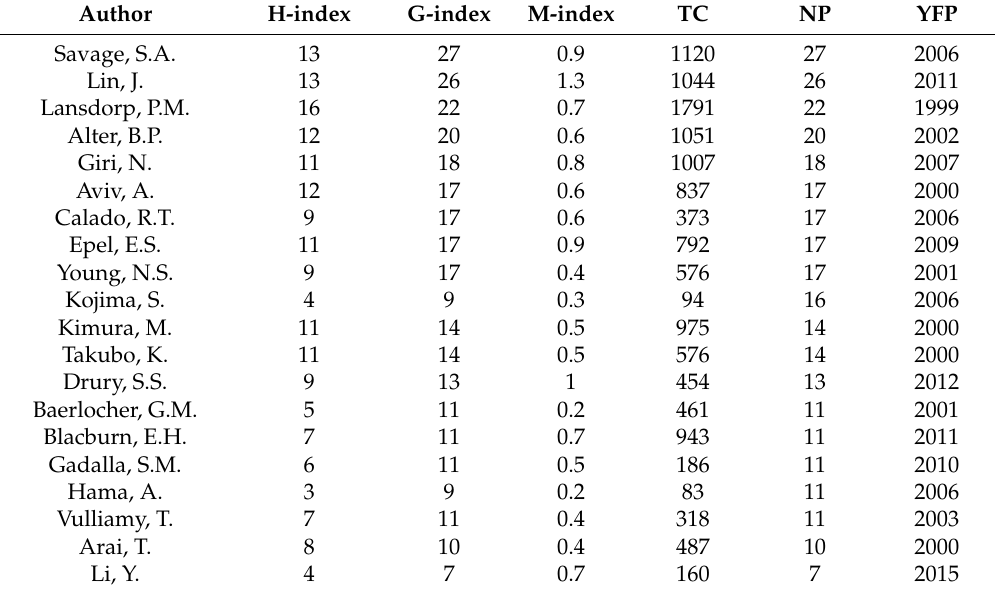
Table 4. Top 20 most cited authors publishing on telomere length in children sorted by number of